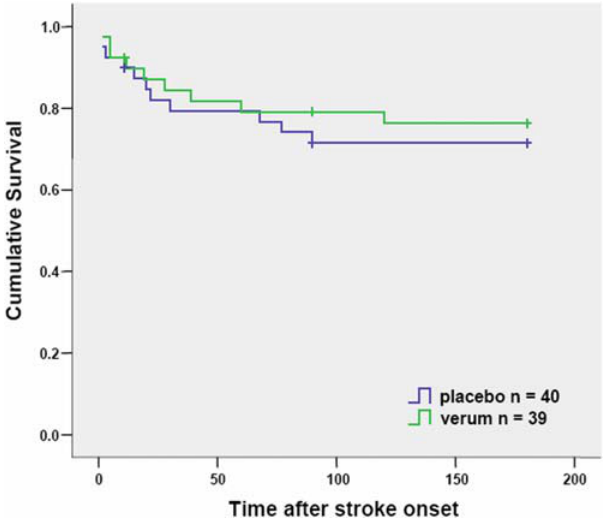
Figure 3. Kaplan-Meier curves of survival in both treatment groups. Crosses indicate time points when patients were lost to follow-up (‘censored’; n=7; verum n=3, placebo n=4 placebo). Seven (verum n=3, placebo n=4) of 79 patients (8.9%) died within 11 days after stroke onset. Within 6 month after stroke 13 (verum n=6, placebo n=7) of 72 patients (18.1%) died.